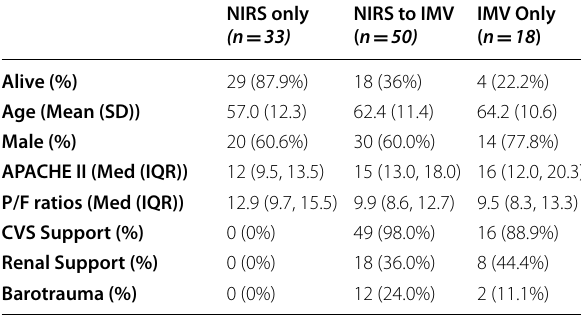
Table 1—Demographics and outcomes of COVID-19 patients based on therapy received